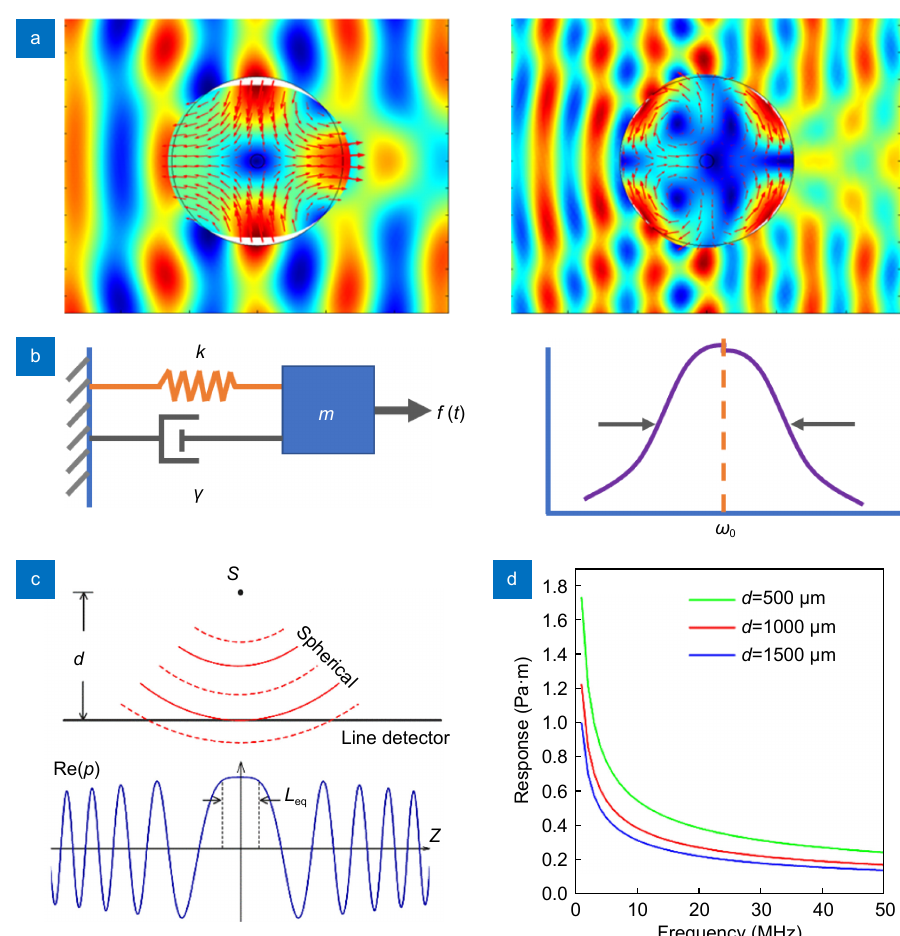
Fig. 1 | ( a ) The calculated deformations of the fiber surrounded by water in response to plane ultrasound waves. Left: TR 21 mode at 22 MHz. Right: TR 22 mode at 39 MHz. Arrows: local displacement. ( b ) Analogous model of a spring-mass oscillator. ( c ) Schematic of the phase cancela- tion effect. ( d ) Frequency responses with different source-to-fiber